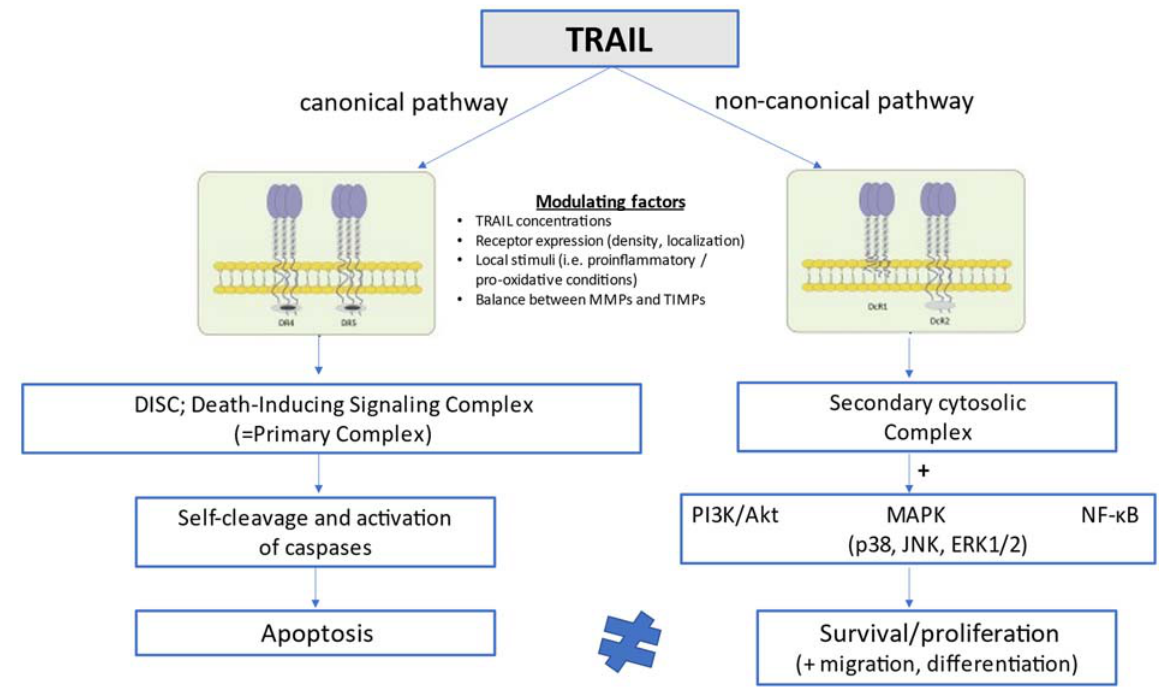
Figure 1 . Schematic presentation of TRAIL signaling pathways at the cellular level. Figure 1. Schematic presentation of TRAIL signaling pathways at the cellular